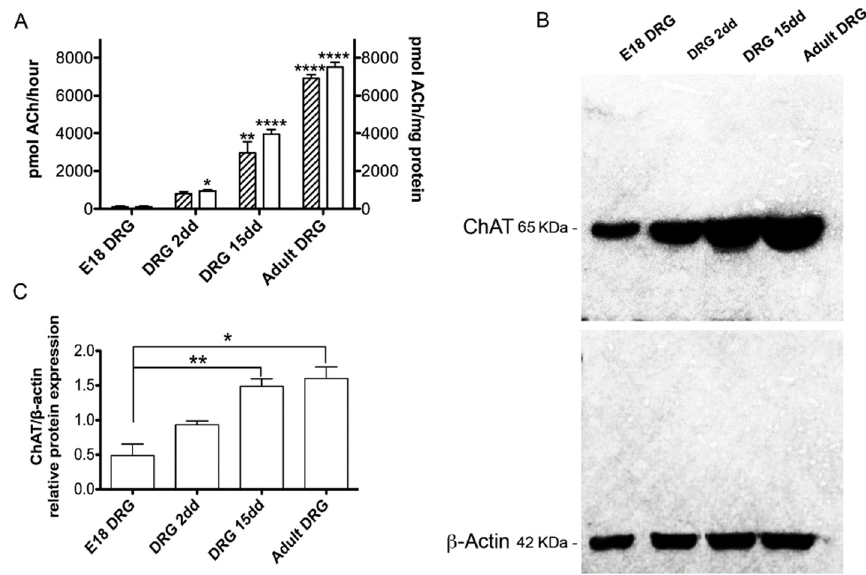
Figure 5. ( A ) ChAT activity was measured in DRG extracts at the E18, DRG 2dd; DRG 15dd; Adult DRGs. ChAT activity was reported as the total activity (pmol ACh tot/h) or specific activity (pmol ACh synthesized/mg of protein/h). All the samples were compared with the respective E18 DRG sample. Data are the mean ± SEM of at least 3 independent experiments performed in duplicate. ( B ) Representative Western blot analysis of the ChAT protein at E18, DRG 2dd; DRG 15dd; Adult DRGs. The graph ( C ) shows the densitometric analysis of the bands obtained after normalization with β -actin used as a protein reference. The data are the mean ± SEM of four independent experiments. All the samples were compared with the respective E18 DRG sample. (* p < 0.05; ** p < 0.01; **** p < 0.0001).